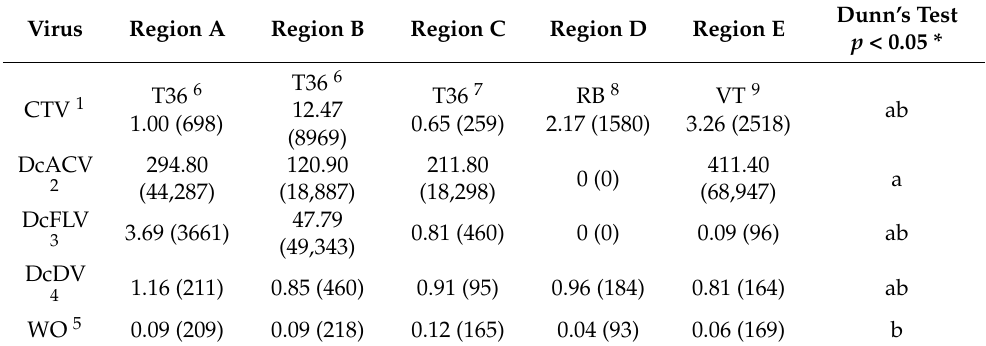
Table 4. Abundance of viruses (with detected contigs of interest) in Group 2019 Florida Regions A–E.